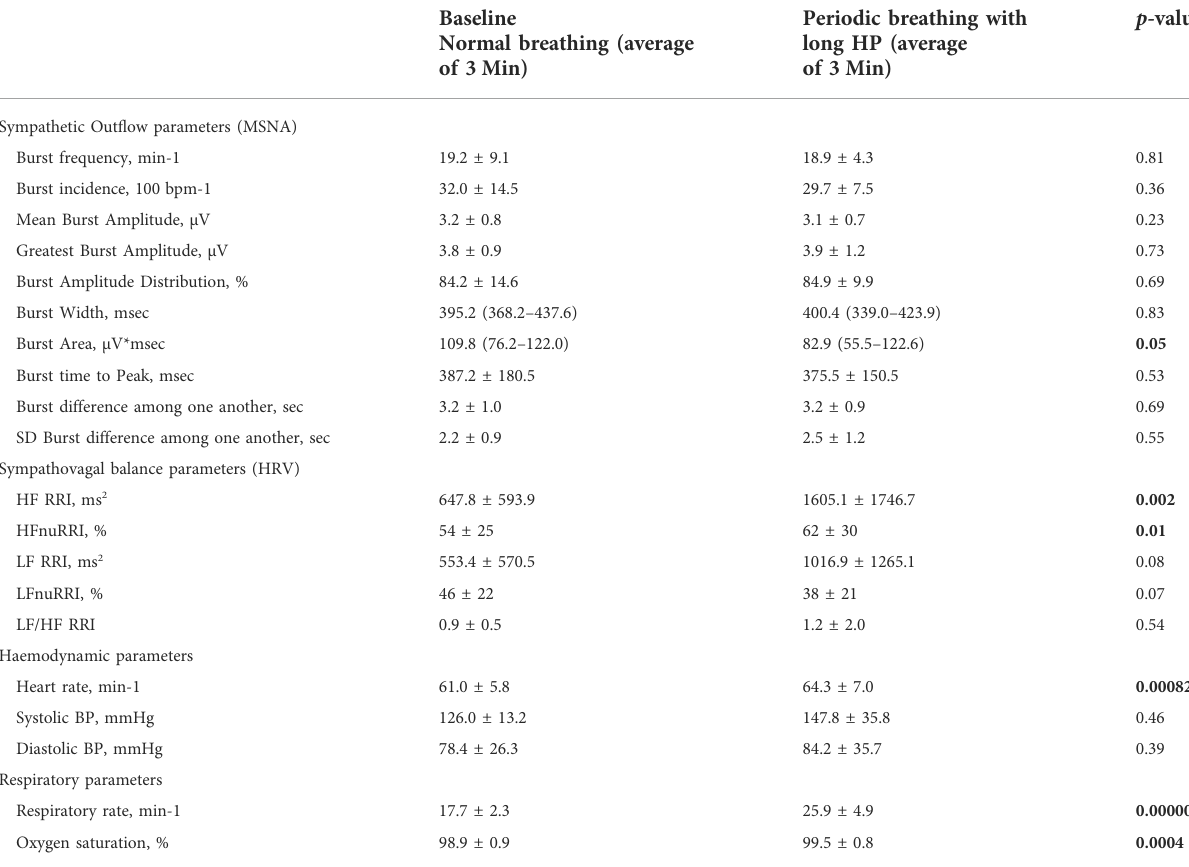
TABLE 2 Comparison of sympathetic out fl ow, hemodynamic and respiratory data between normal breathing and periodic breathing with a long hyperpnea length.